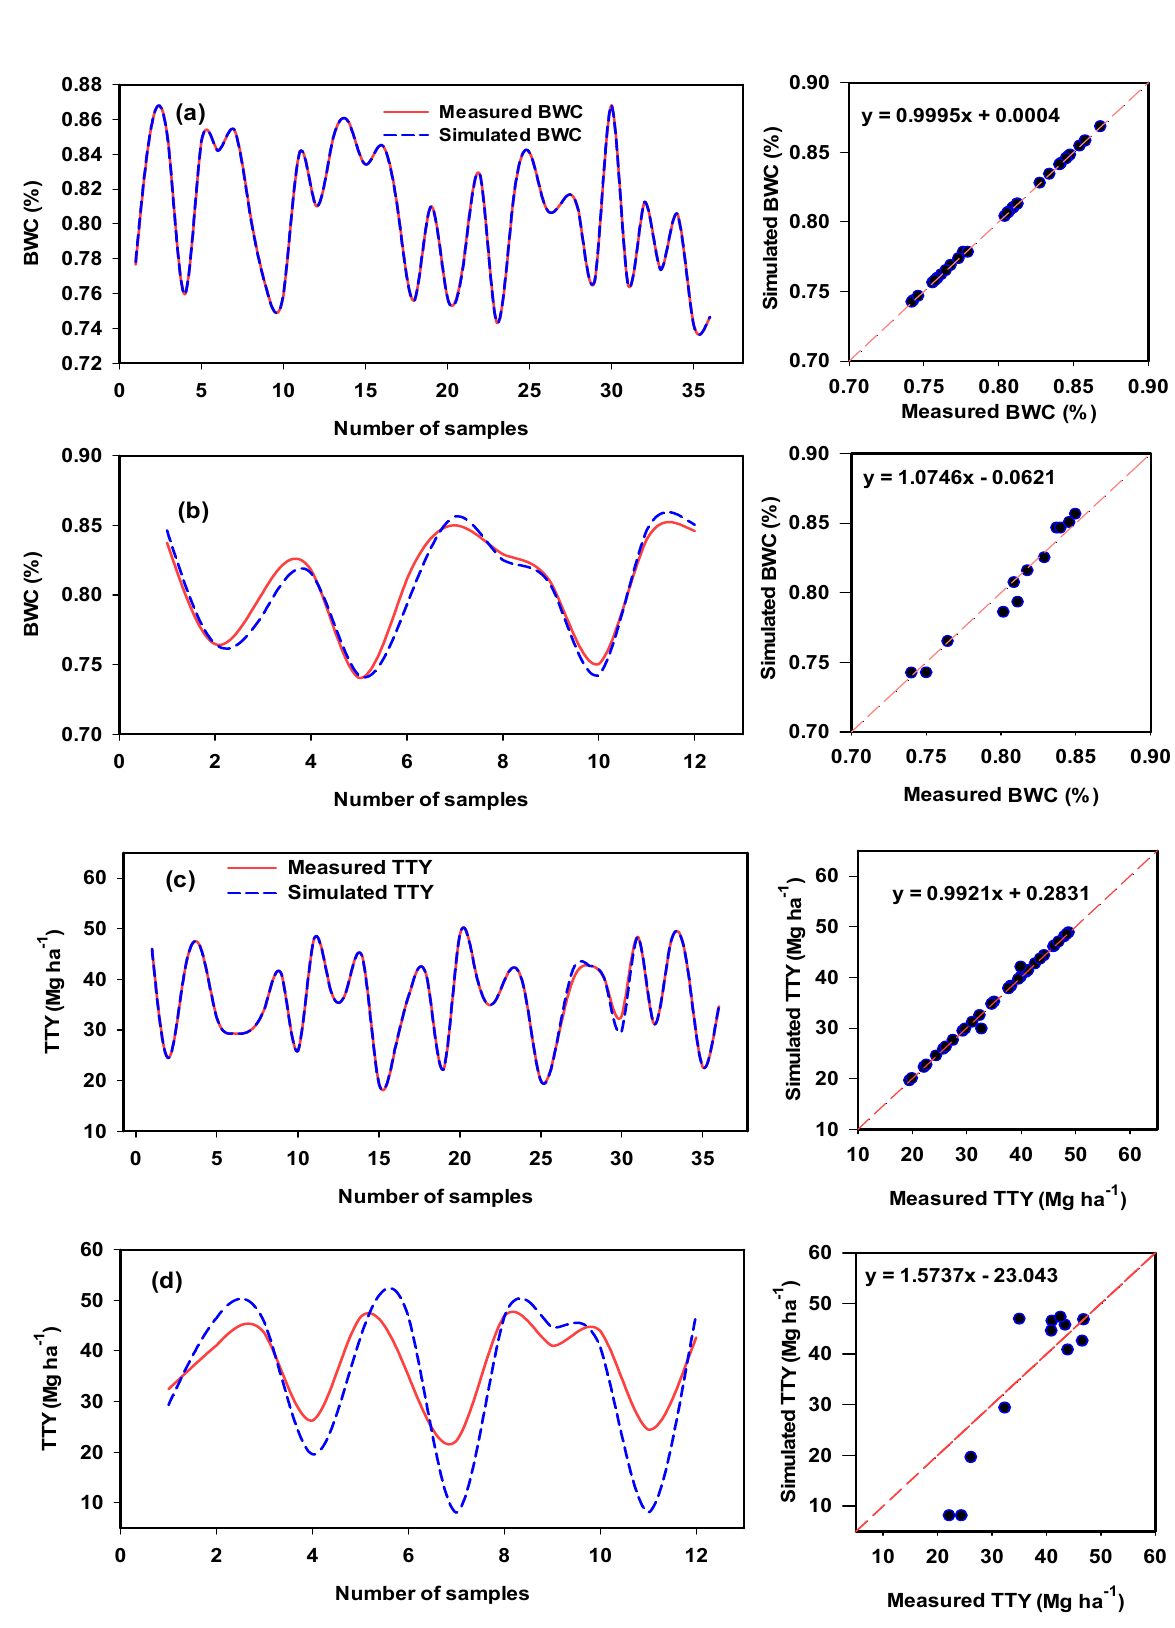
Figure 12. Comparison between training series ( a , c ) and testing series ( b , d ) for biomass water content (BWC) and total tuber yield (TTY) of potato varieties using the developed ANFIS model.